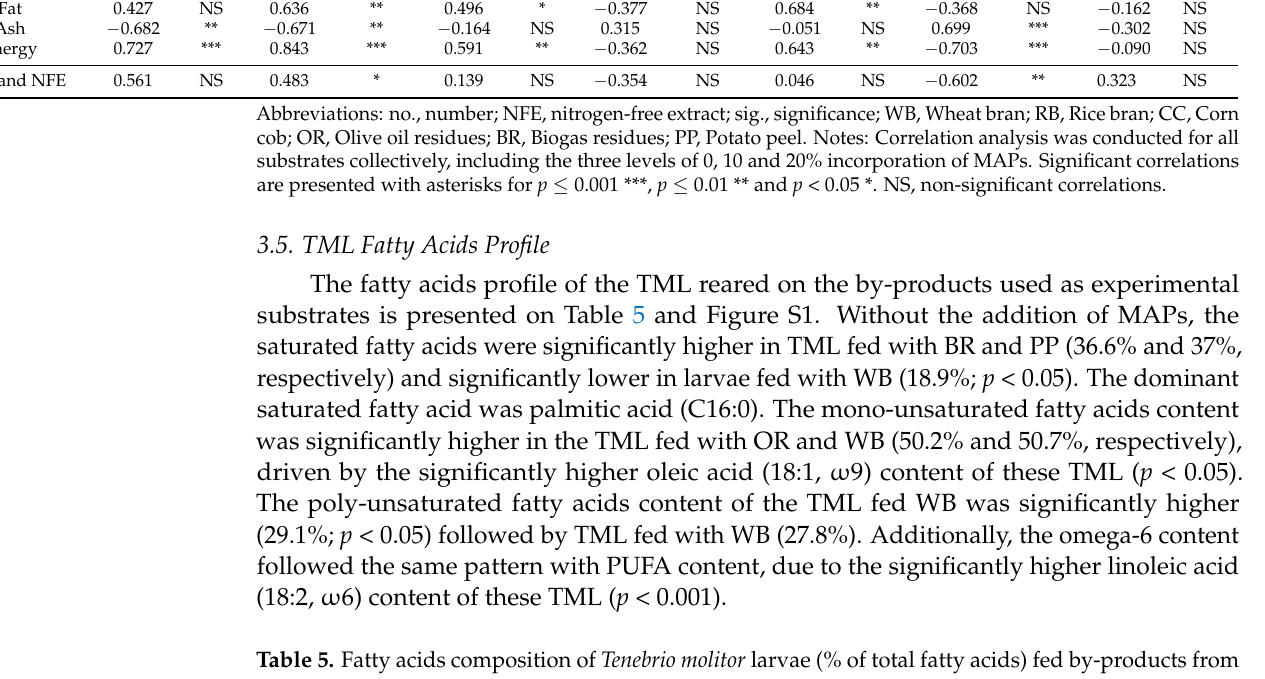
Table 5. Fatty acids composition of Tenebrio molitor larvae (% of total fatty acids) fed by-products from agri-food industry supplemented with 0, 10% or 20% distillation residues of Medicinal Aromatic Plants